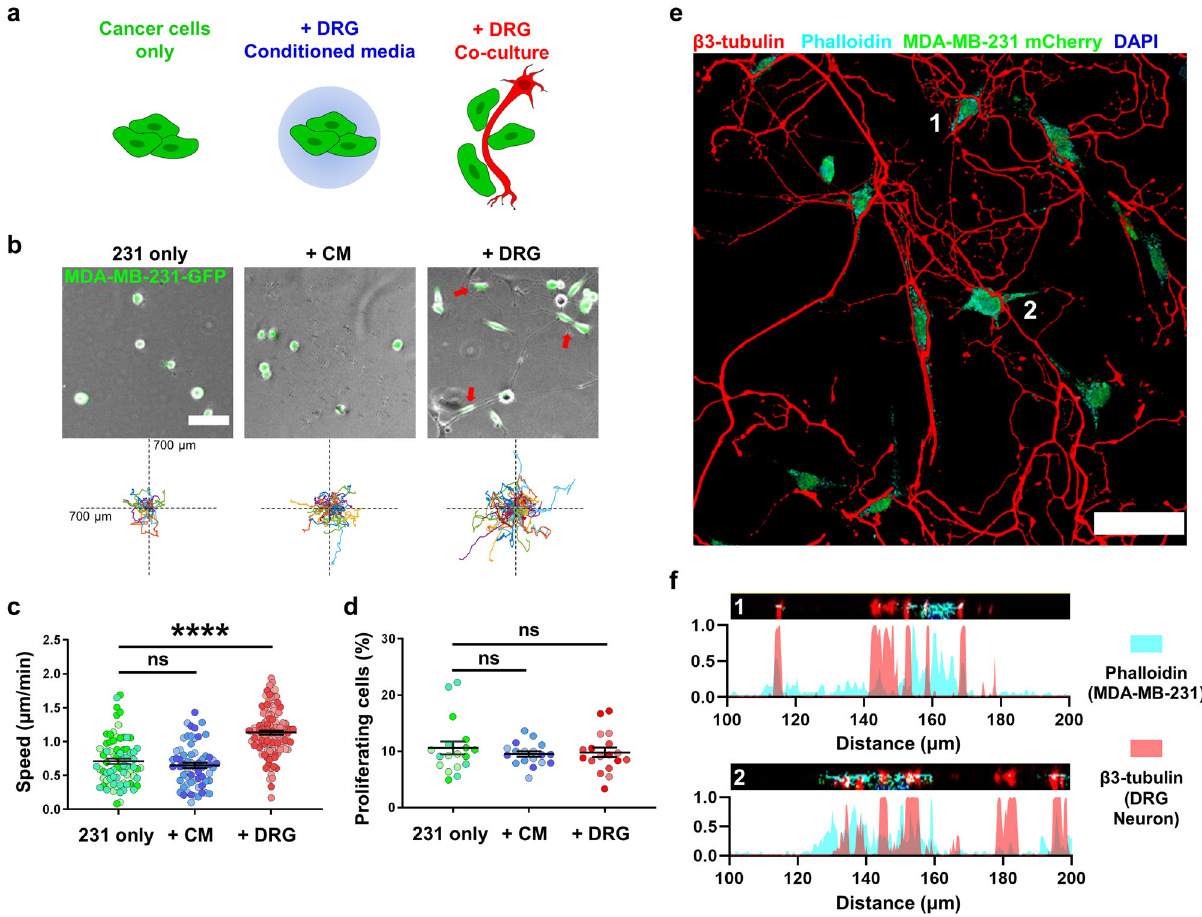
Fig. 3 DRG sensory neurons in co-culture increase MDA-MB-231 TNBC cell migration in vitro. a Schematic for experimental setup. b Representative images and Rose plots displaying the migration track of GFP-tagged 231 cells over 16 h, red arrows denoting cells attached to neuron fi bers, scale bar denoting 100 μ m. c 2D migration speed of 231 cells, each point represents the average speed of one tracked cell over 16h, n ≥ 150 cells per condition. d Quanti fi cation of 231 cells undergoing proliferation in tracking period, each point represents a fi eld of view, n ≥ 10 per condition. Data show mean ± SEM. Different shades of color represent cells from different biological replicates. Signi fi cance was determined by one-way ANOVA. (** p < 0.01, **** p < 0.0001). e Immunostaining of m-Cherry tagged 231 co-cultured with DRG, with β 3- tubulin staining for neuron fi ber and Phalloidin staining for F-actin. Volume was constructed using 5 μ m z-stacks with 0.5 μ m step size, scale bar denoting 50 μ m. f Orthogonal slices of cells numbered 1,2 in e (black bar) with plots showing normalized fl uorescent signal intensity of Phalloidin and β 3-tubulin signal. Distance represents distance across image